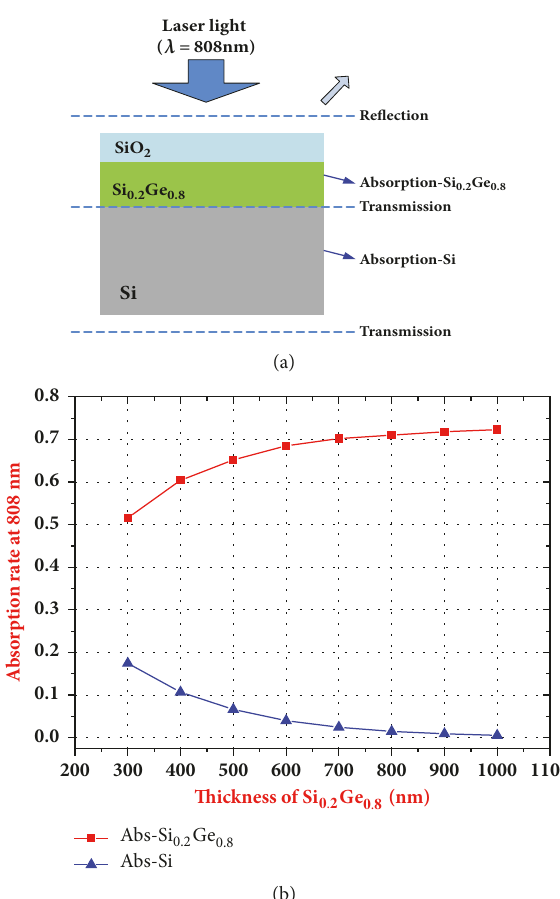
Figure 5: (a) Schematic diagram of the laser reflection, absorption, and transmission (here the SiO2 capping layer is used here to protect the Ge film from damage). (b) Absorption rates at 𝜆 =808 nm of Si 0.2 Ge 0.8 and Si layer as a function of Si 0.2 Ge 0.8 thicknesses.